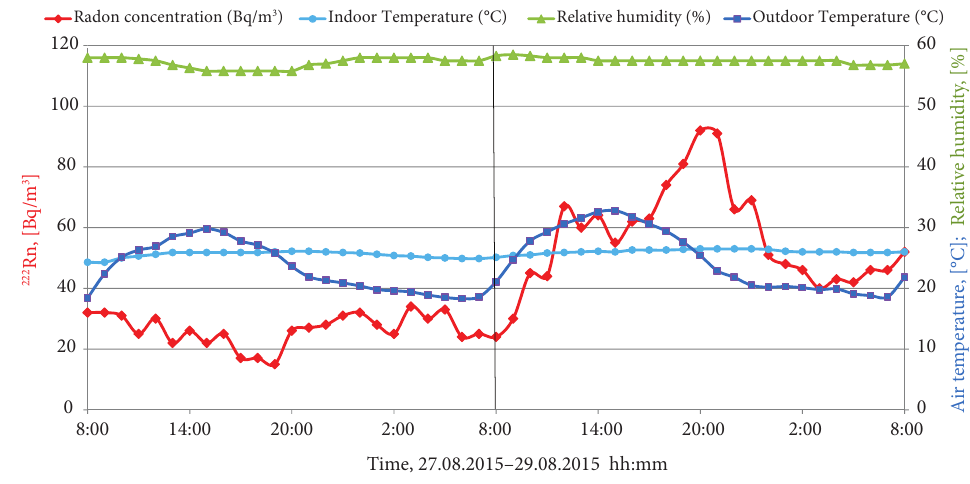
Figure 5. Indoor radon concentration in 2015 summer at Gö5 house in case of 2 day measurement, with and without ventilation